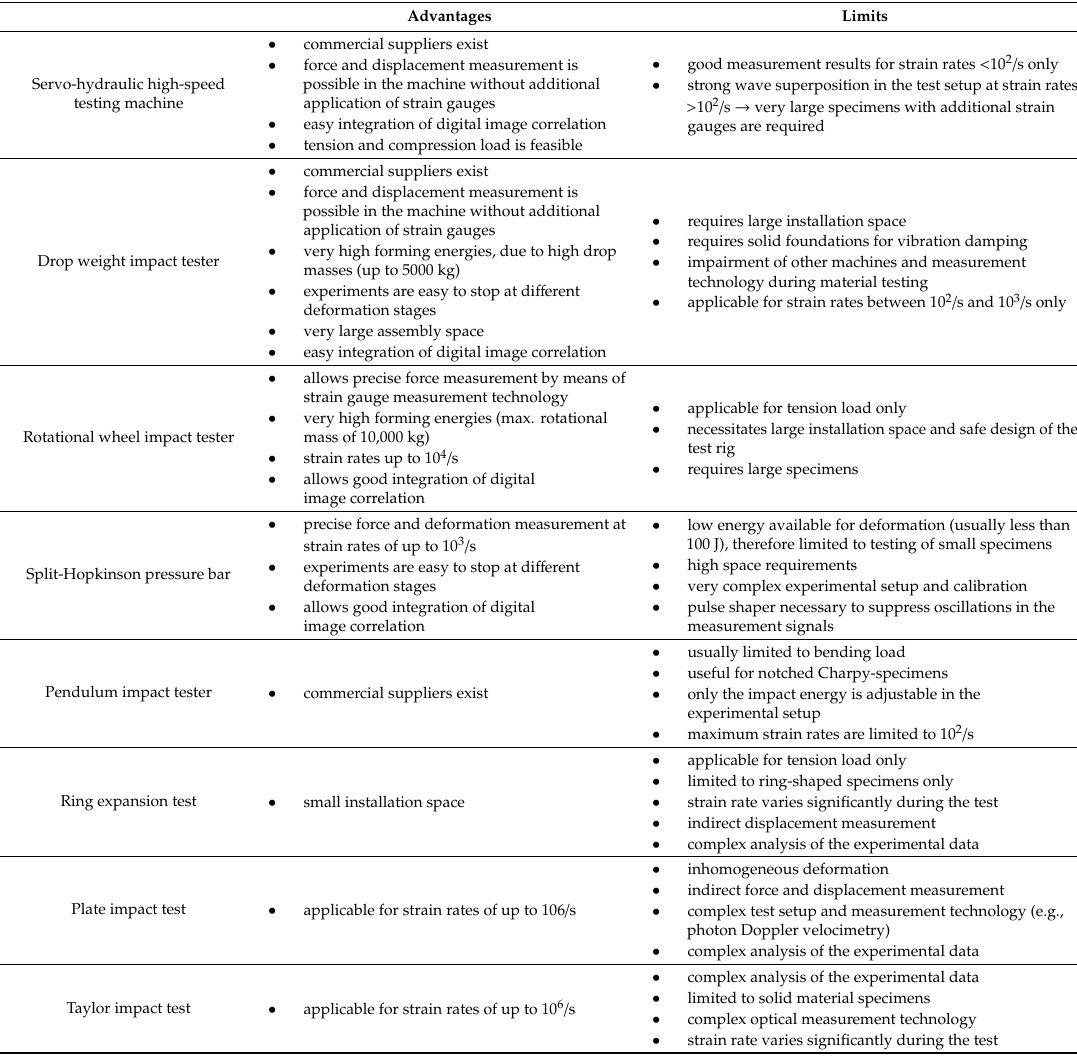
Table 1. Comparison of advantages and limits of di ff erent high-speed testing